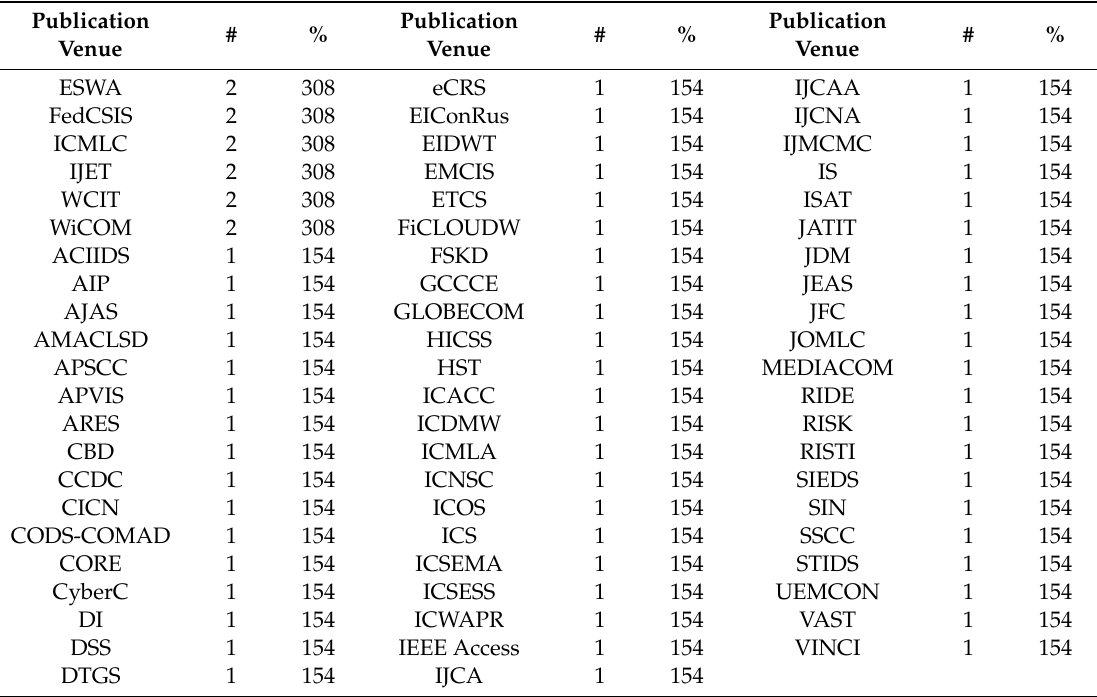
Table 6. Distribution of the selected studies on publication